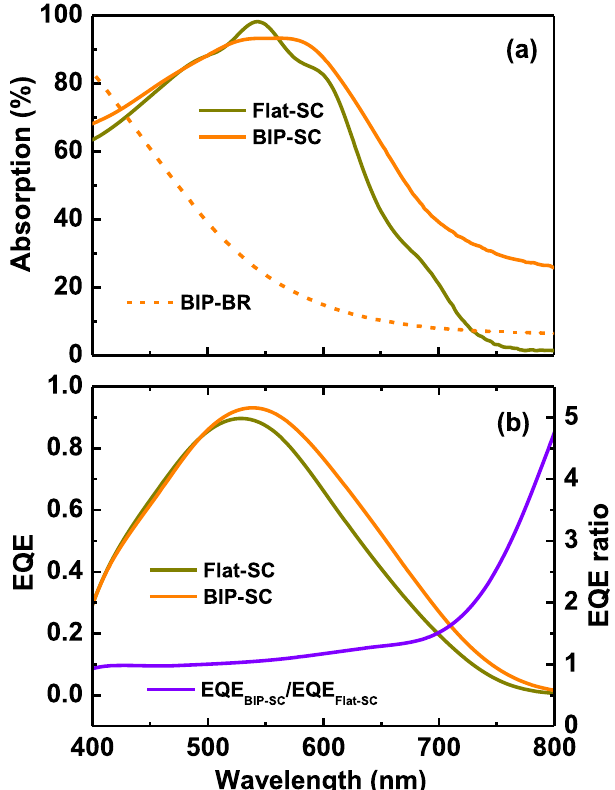
Fig. 5. (a) Total optical absorption by Flat-SC and BIP-SC devices(solidlines),andparasiticabsorptionbytheBIP-BR(dashed line); (b) measured EQE (left-hand side y -axis) spectra of Flat- SC and BIP-SC devices and EQE ratio (right-hand side y